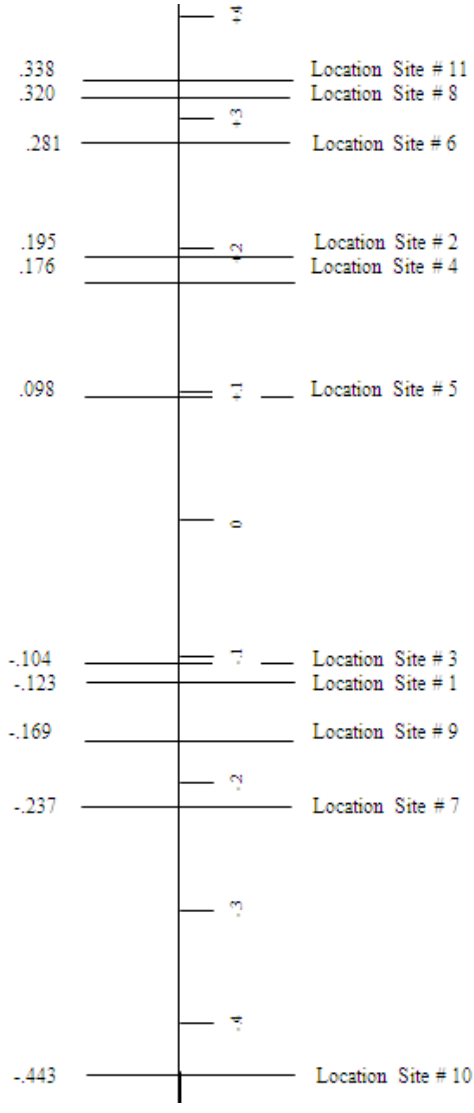
Fig. 2. Linear scale depicting Guttman scores for distribution center location preference